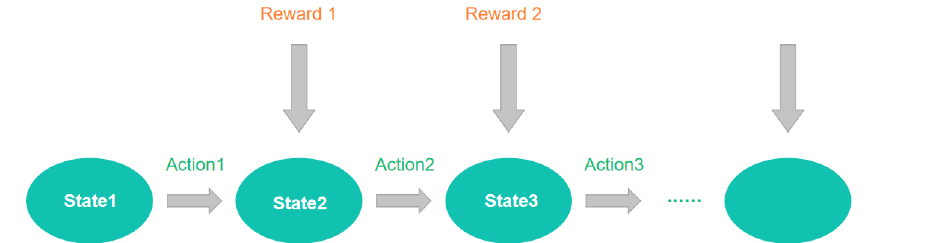
Figure 6. The Markov decision